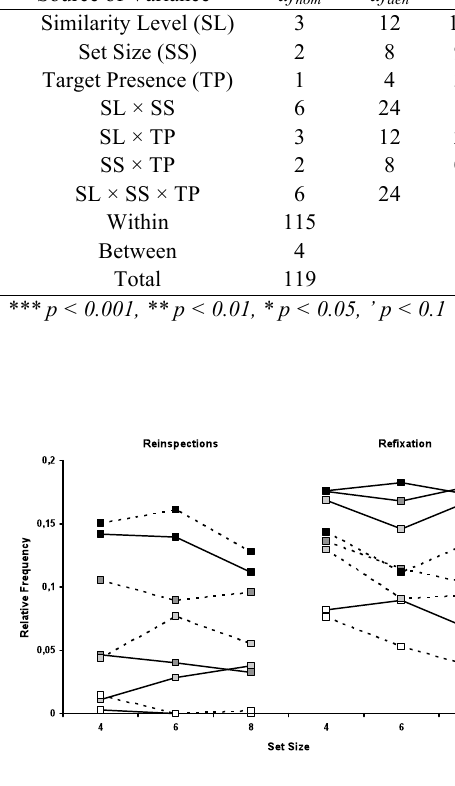
Figure 9. Mean (n = 5) portion of reinspections and refixations in the four levels of similarity and for target- present trials and target-absent trials (dotted lines) with increasing item